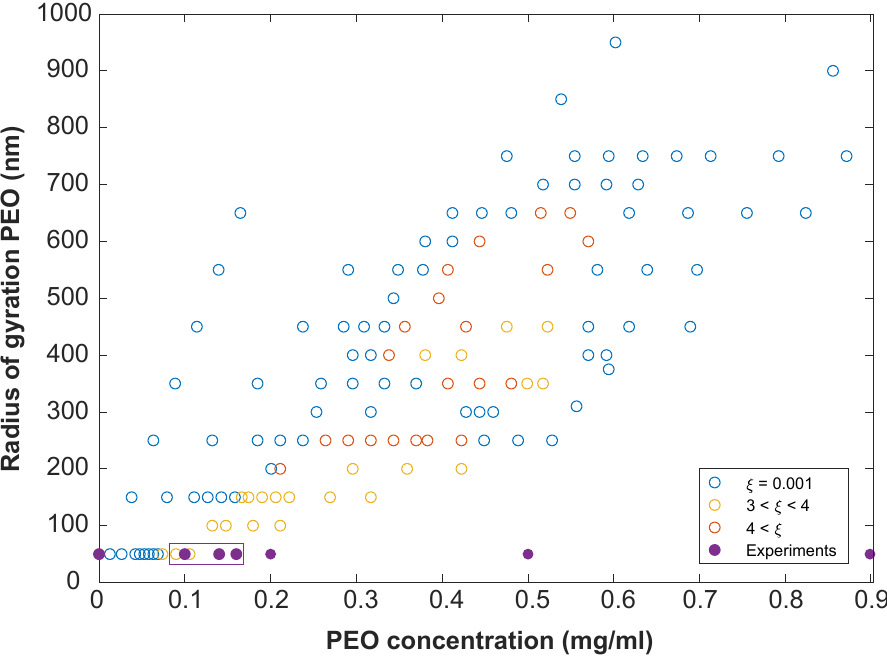
Figure 5. Phase diagram. Spontaneous symmetry breaking as a function of the radius of gyration and the concentration of PEO. Open circles indicate the theoretical results obtained by Pickett et al. [9]. These are colour-coded with the chiral order parameter, i.e., the amount of chirality of a structure. The blue open circles are achiral states whereas the yellow and orange open circles indicate two different chiral states. The filled circles are the experimental data points as discussed in this Article. The points enclosed inside the box are chiral, whereas those outside of the box are achiral. One point overlaps. Experimental data points were obtained in a homogeneous magnetic field of 1.4mT with silica particle concentration of 50mg/mL and 10mM salt.